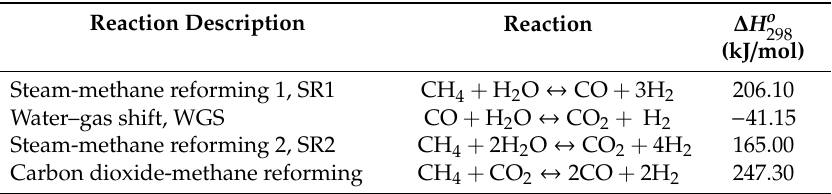
Table 1. Steam methane reformer (SMR) reactions used in the